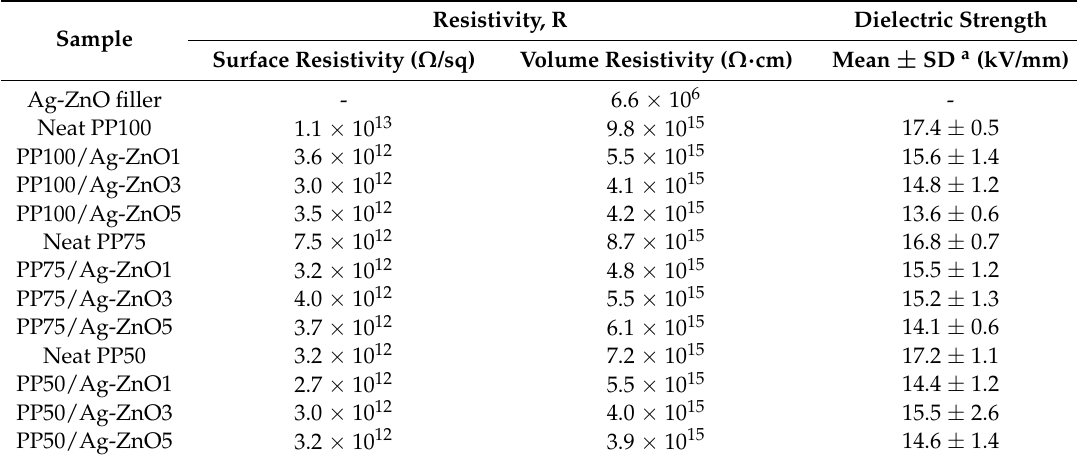
Table 3. Electrical properties of the